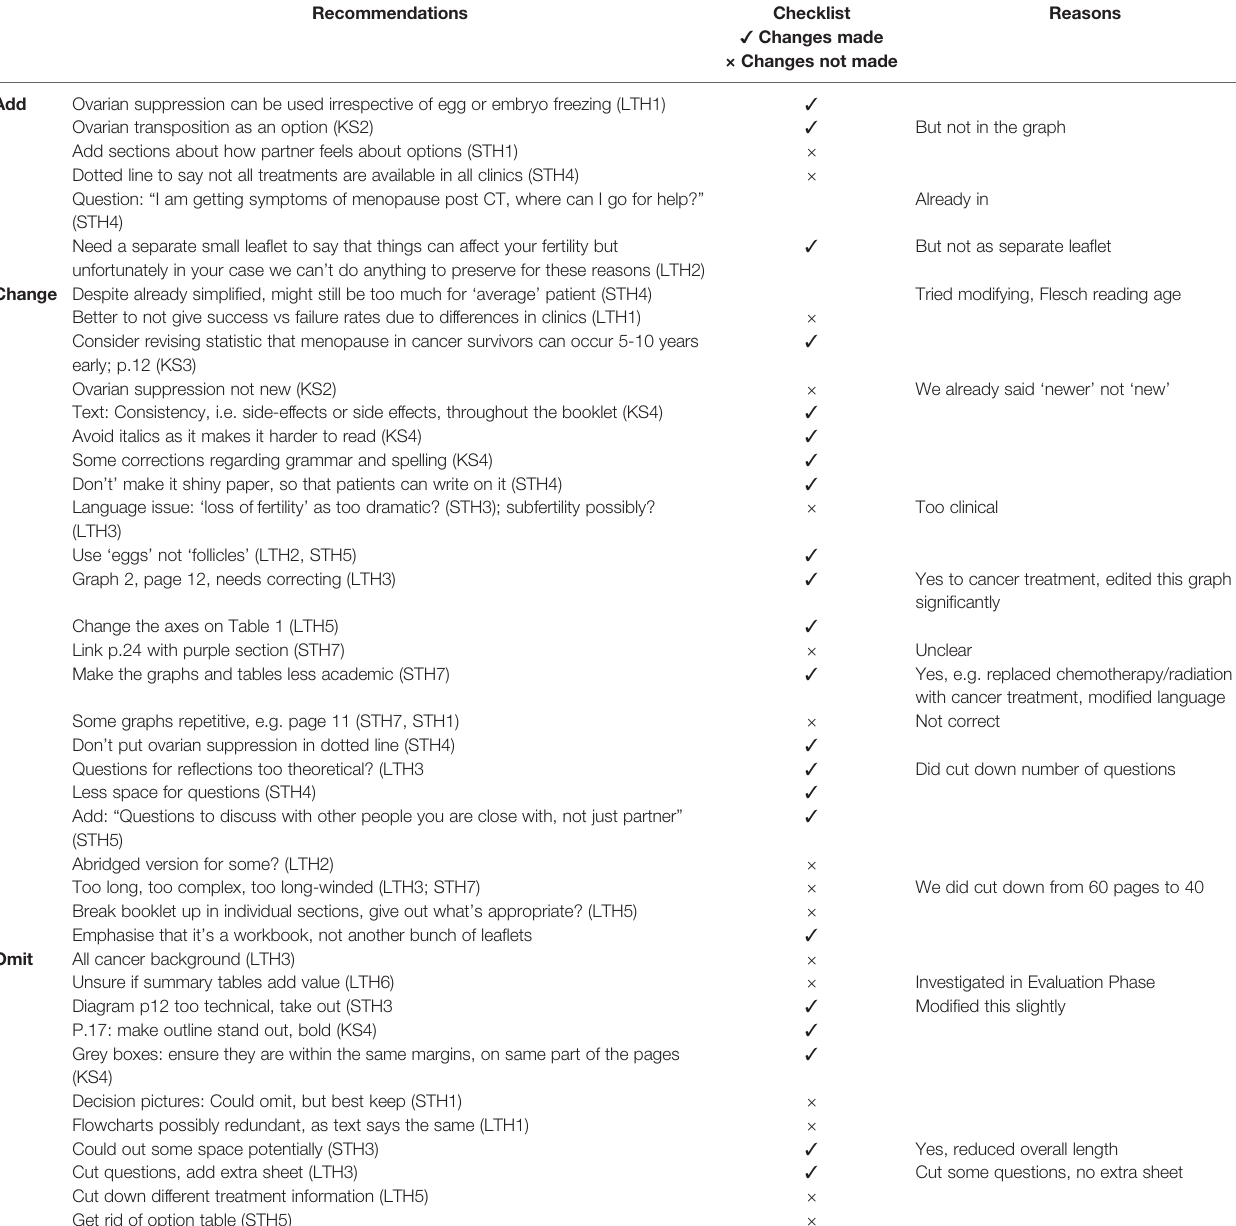
TABLE 5 | Practical recommendations made by the healthcare professionals and key stakeholders following alpha testing.